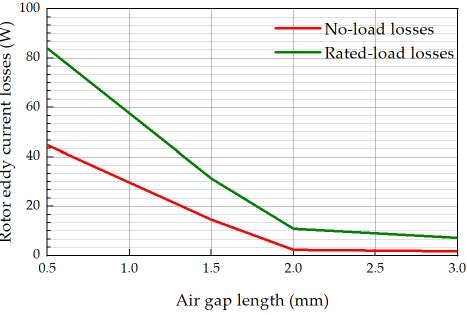
Figure 4. Effect of air ‐ gap length on rotor eddy ‐ current losses under no load and rated load.